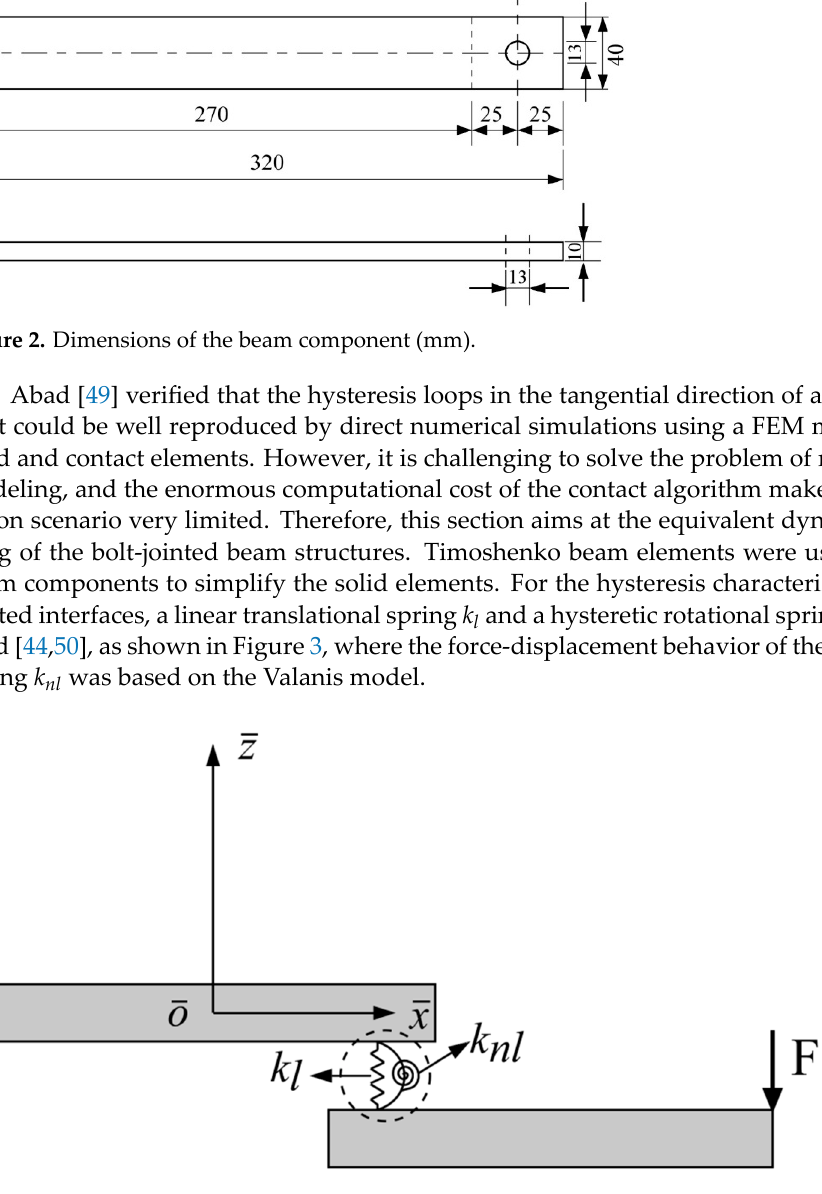
Figure 3. Equivalent dynamic model of the cantilevered bolt-jointed beam.